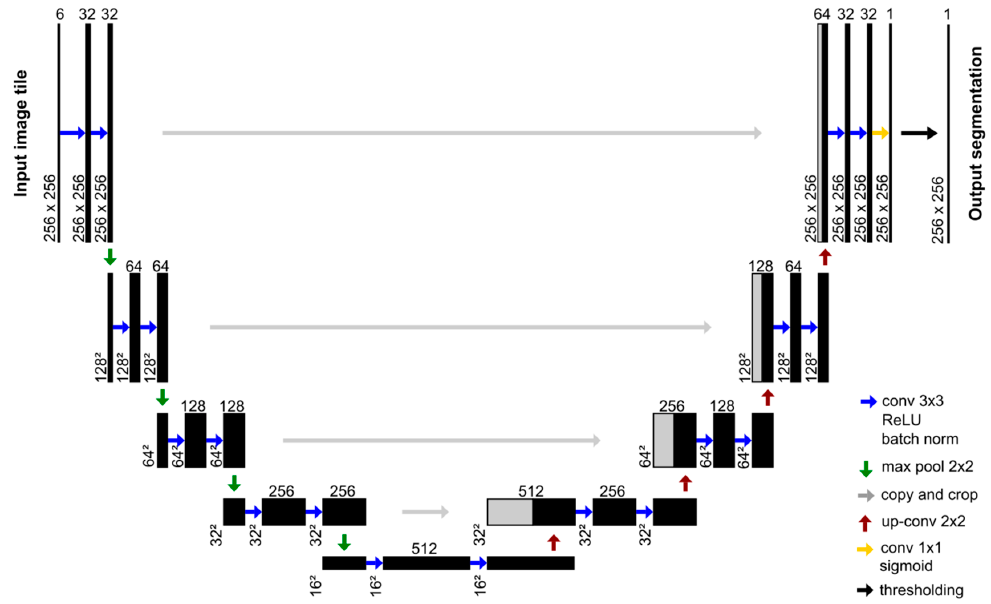
Figure 4. Architecture of the U-Net used in this work (modified from [43]).